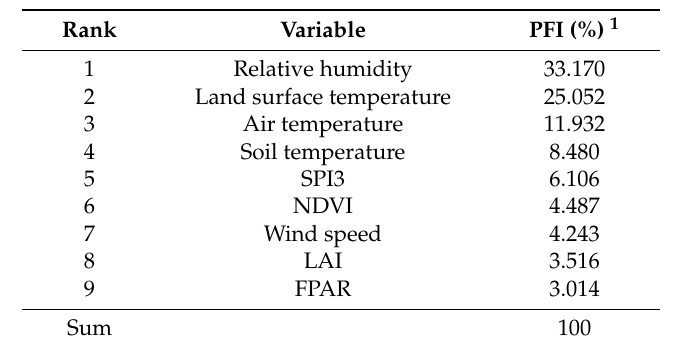
Table 3. Importance of the input variables of the ML-based daily ET 0 model in the croplands of South Korea, 2013–2019.